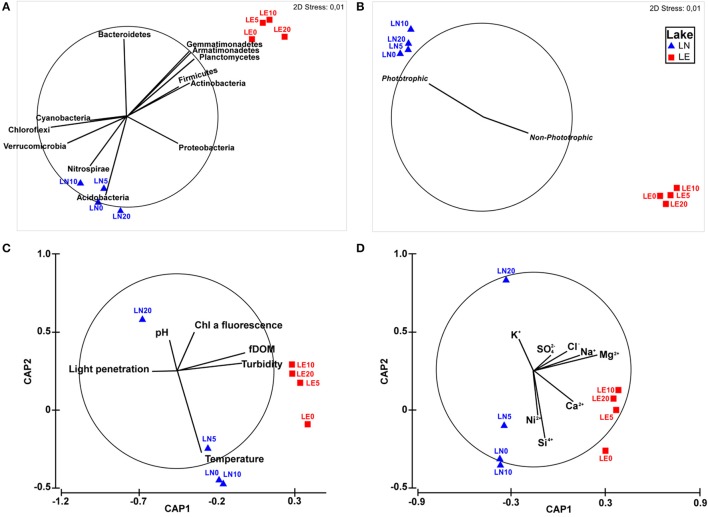
(A) Non-metric multidimensional scaling for OTUs, with vectors overlay showing the correlation of principal phyla. (B) Non-metric multidimensional scaling for Genus of the principal Phyla, with vectors overlay showing correlation with phototrophy. (C) Canonical analysis of principal coordinates (CAP) for OTUs data with vectors overlay showing physical variables. (D) Canonical analysis of principal coordinates OTUs with vectors overlay showing chemical variables.